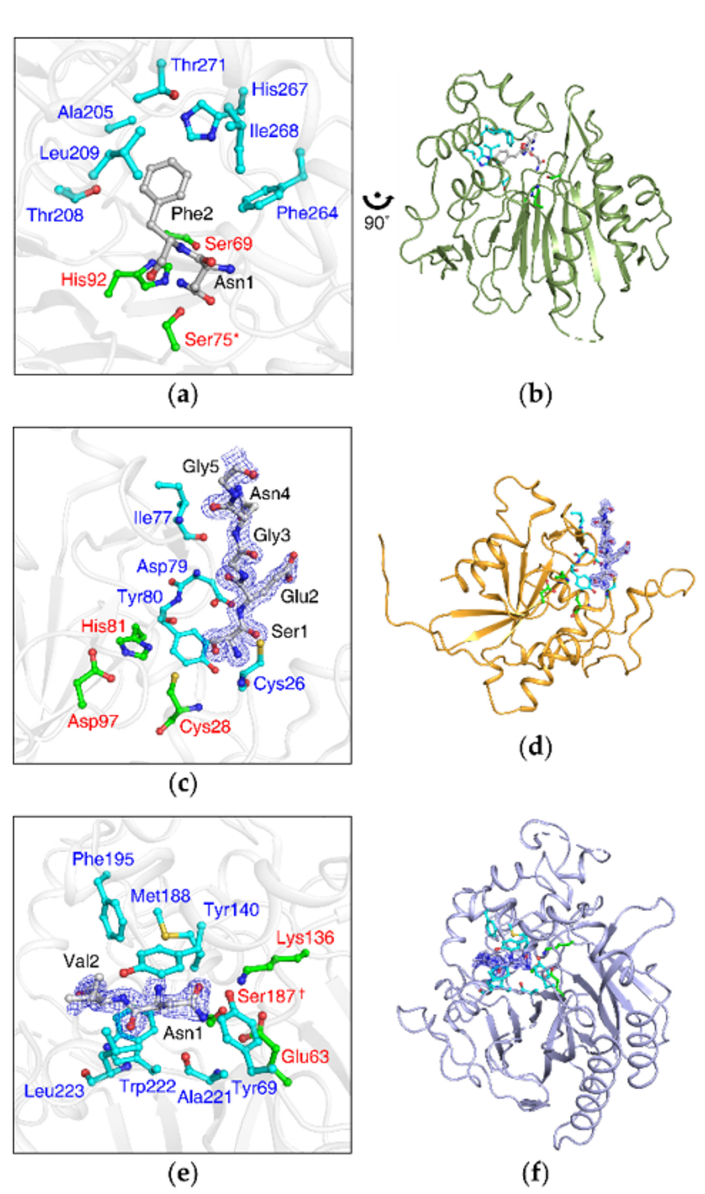
Figure 4. Crystal structures of NTAN1, NTAQ1, and yNta1 exhibit di ff erent substrate-recognition modes. ( a ) NTAN1 residues accommodating the second-position residue of substrates. Catalytic triad (Cys75 / His92 / Ser69, Cys75 is mutated to Ser75 in the structure and labeled with an asterisk) and the residues interacting with the second-position Phe in the NTAN1 C75S–NFAAR complex are colored in green and cyan, respectively. The bound peptide is colored in gray. Nitrogen and oxygen atoms are colored in blue and red, respectively. ( b ) Overall structure of NTAN1. Zoom-out view of ( a ) rotated 90 ◦ anticlockwise. ( c ) NTAQ1 structure in complex with a substrate-mimicking peptide (PDB code: 4W79). Catalytic triad (Cys28 / His81 / Asp97) and the residues forming specific hydrogen bonds with the substrate-mimicking N-terminus of an adjacent NTAQ1 molecule are colored in green and cyan, respectively. The substrate-mimicking N-terminus is colored in gray, and its electron-density map is represented by blue mesh at a 1.5 σ contour level. Sulfur atoms are colored in yellow. ( d ) Overall structure of NTAQ1. Zoom-out view of ( c ). ( e ) Structure of yNta1 C187S mutant in complex with NV dipeptide (PDB ID: 5K62). Catalytic triad (Cys187 / Glu63 / Lys136, Cys187 is mutated to Ser187 in the structure and labeled with a dagger) and the residues interacting with the NV dipeptide are colored in green and cyan, respectively. NV dipeptide is colored in gray, and its electron-density maps are represented by blue mesh at a 1.5 σ contour level. ( f ) Overall structure of yNta1. Zoom-out view of ( e